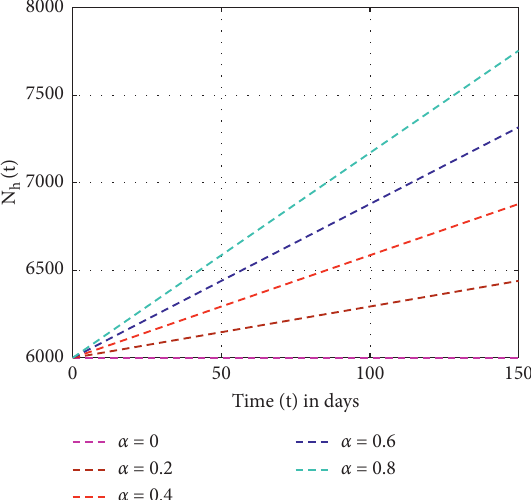
Figure 5: Simulation of total human population size described